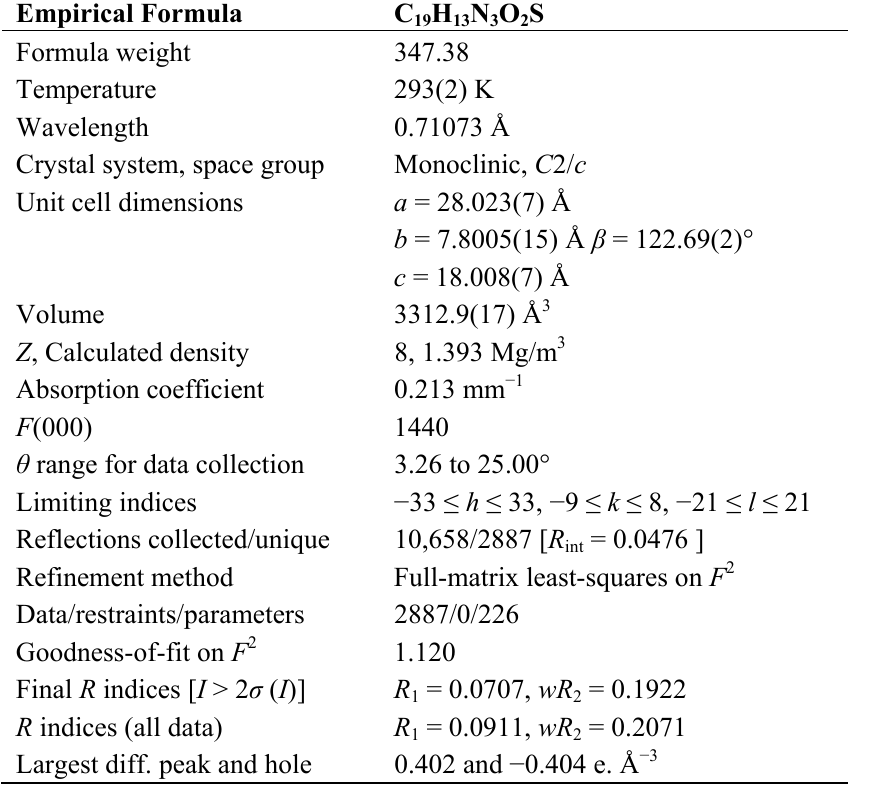
Table 4. Summary of crystallographic results for the title